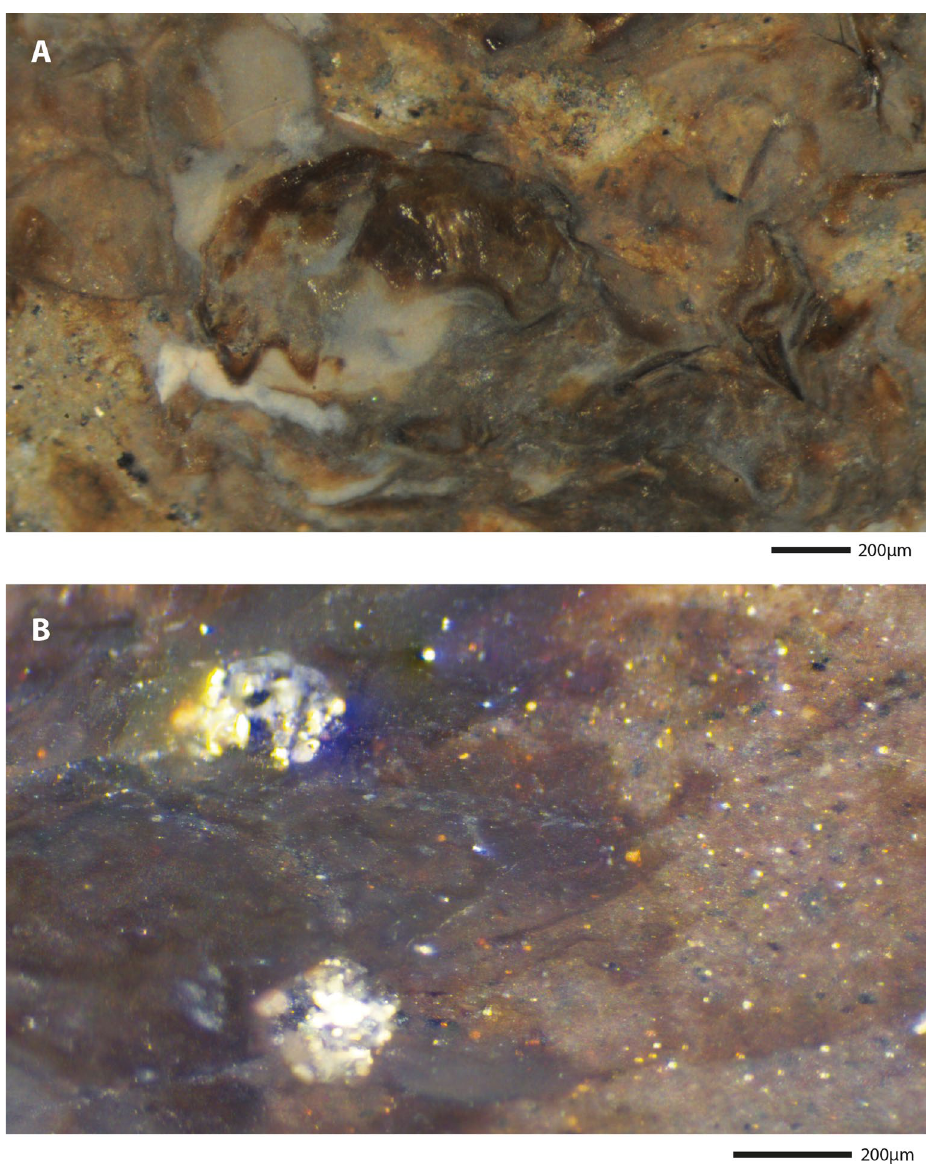
Figure 7. Detail photographs of the holotype Bechleja brevirostris n. sp. ( A ) View of the left mandible (SF-MeI 5933 A); ( B ) View of the rostrum and eyes (SF-MeI 5933